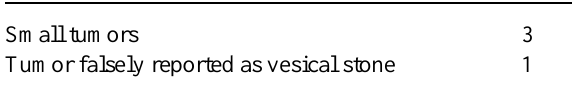
Table 2 – Failure of ultrasonography to detect bladder carcinoma (n =